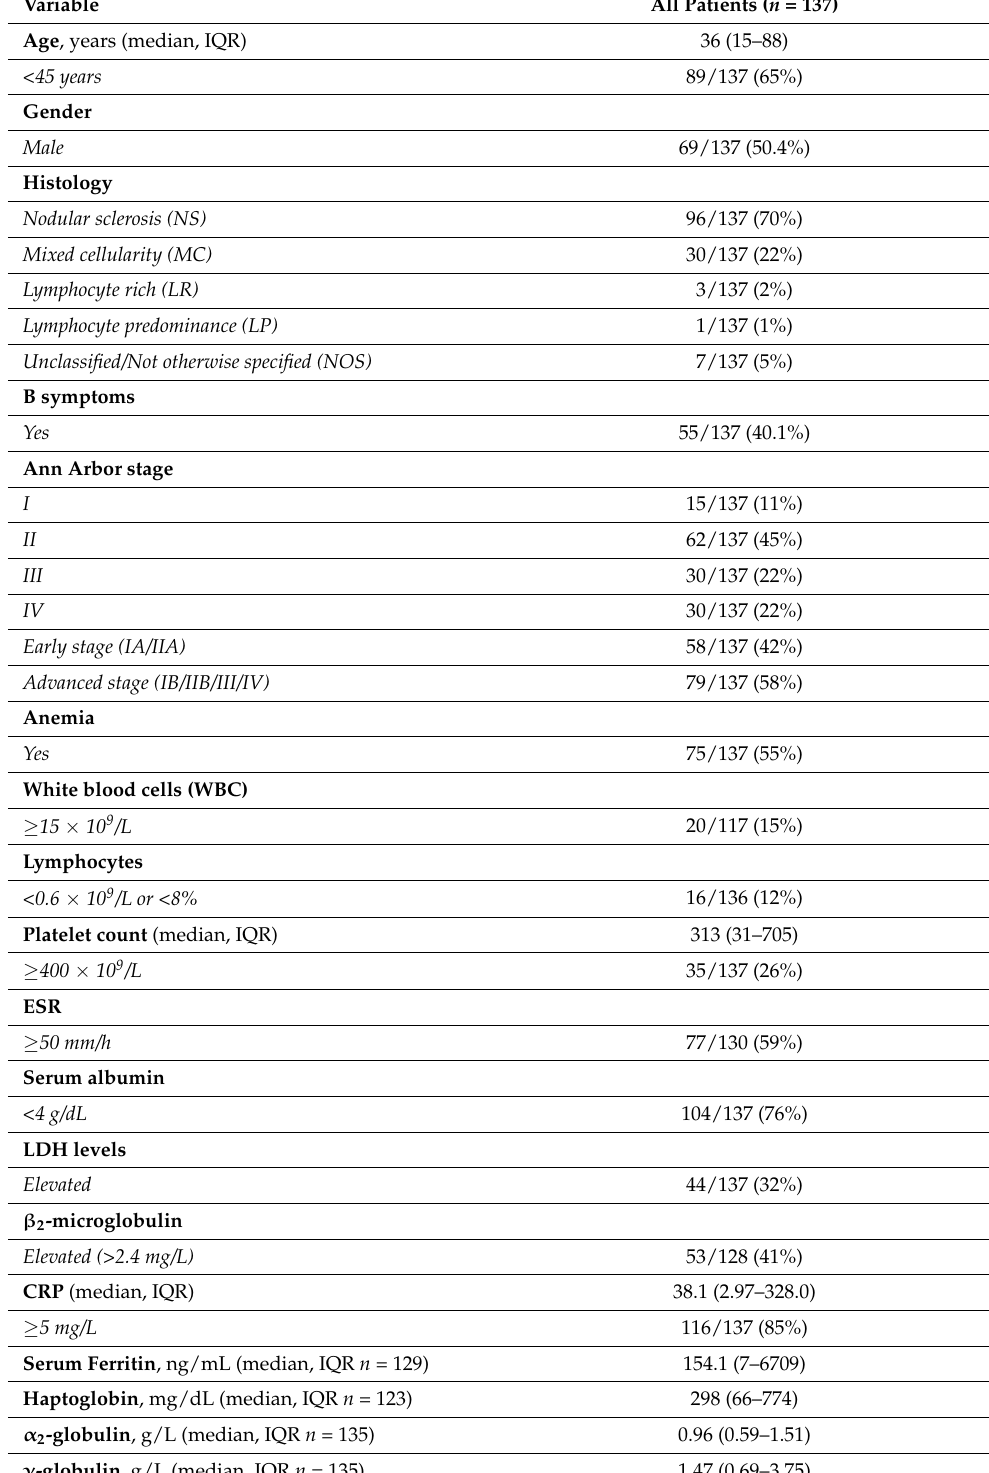
Table 1. Baseline characteristics of 137 patients with HL with available PCT